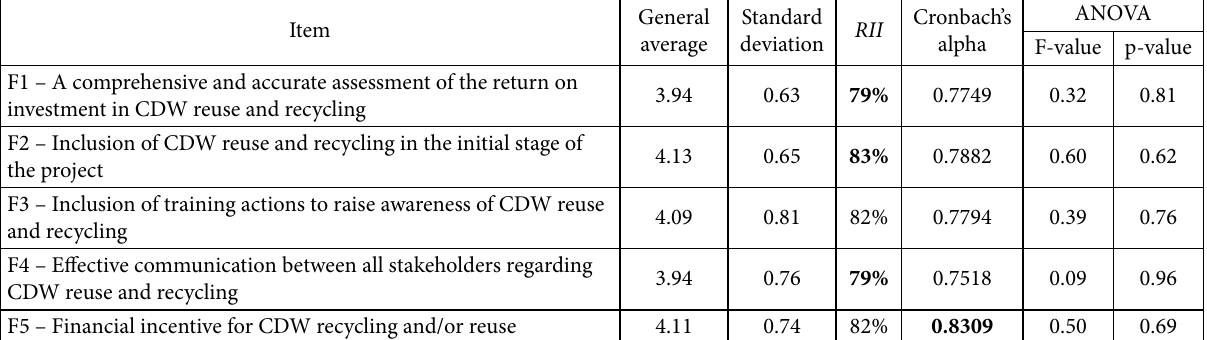
Table 10. Analysis of the general survey sample data regarding the factors that promote CDW reuse and